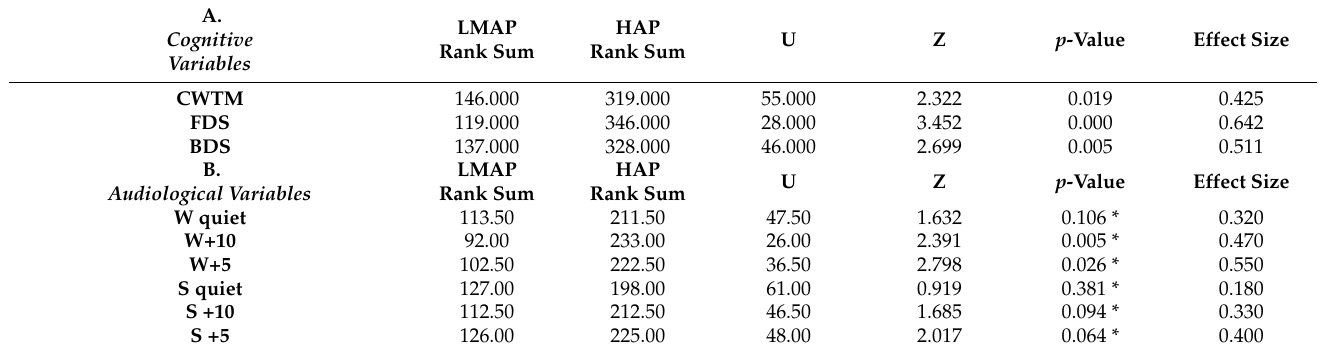
Table 3. The table shows the differences between the LMAP and HAP subgroups for dependent cognitive variables, measured with the Mann–Whitney U test and adjusted with Bonferroni correction for multiple comparisons. Significant correlations are shown in bold. For multiple comparisons (word and sentence recognition) with Bonferroni correction, p -values were ≤ 0.017 (*).